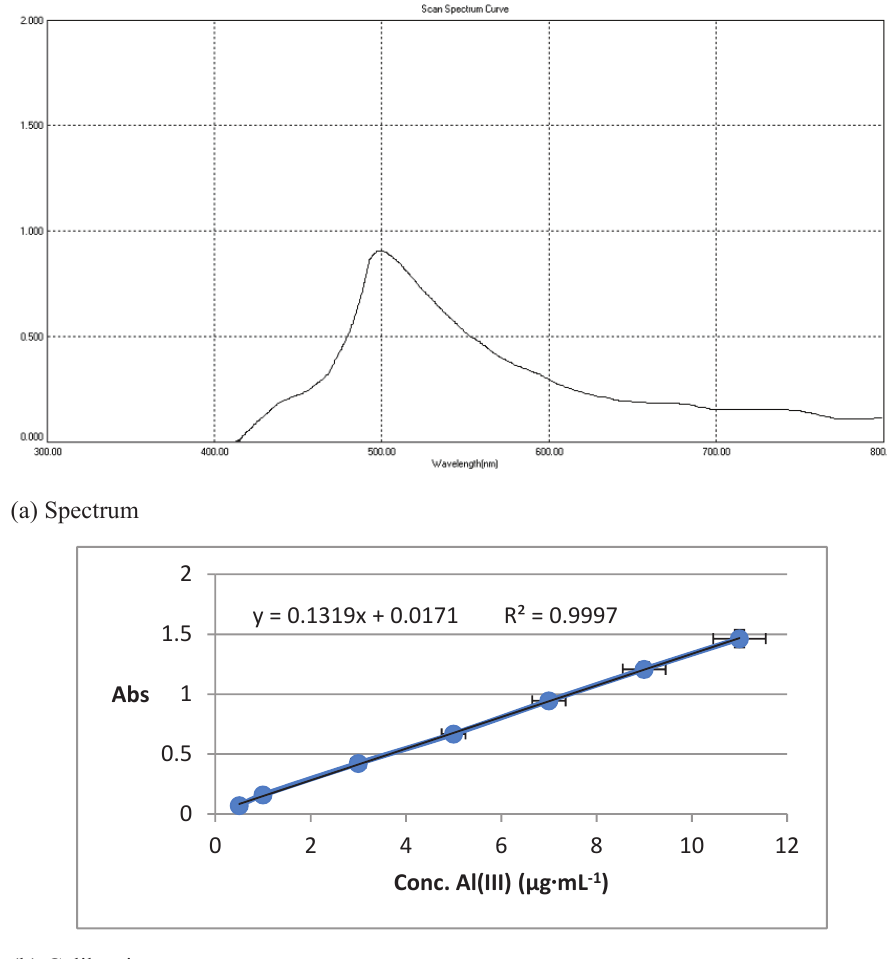
Figure 20: Absorption spectrum (a) and calibration curve for aluminum complex (b).